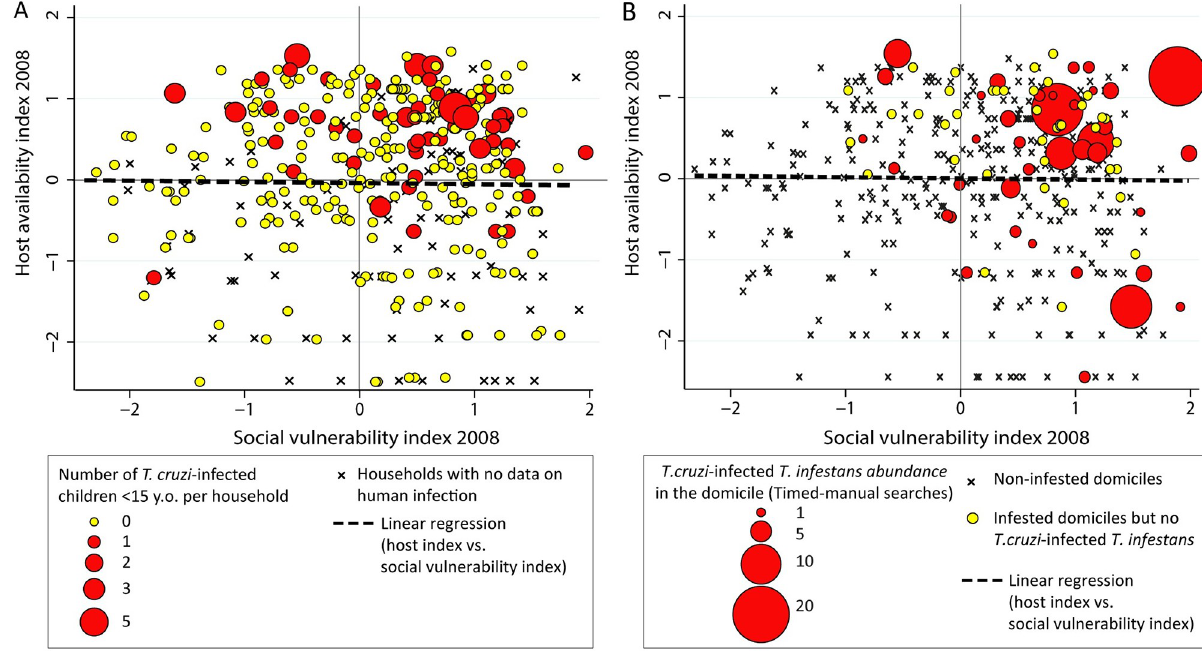
Fig 3. Multivariate relationship between household-level host availability, social vulnerability and vector indices [54] (A) and child seropositivity for T . cruzi infection (B), Pampa del Indio, Argentina.